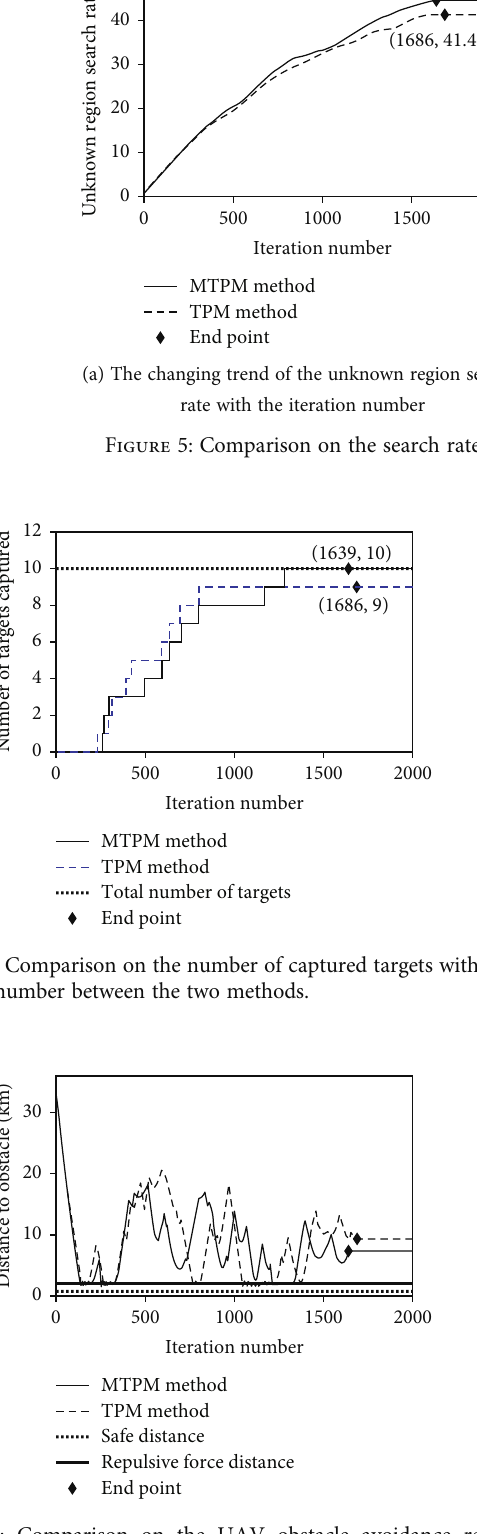
Figure 7: Comparison on the UAV obstacle avoidance result between the two